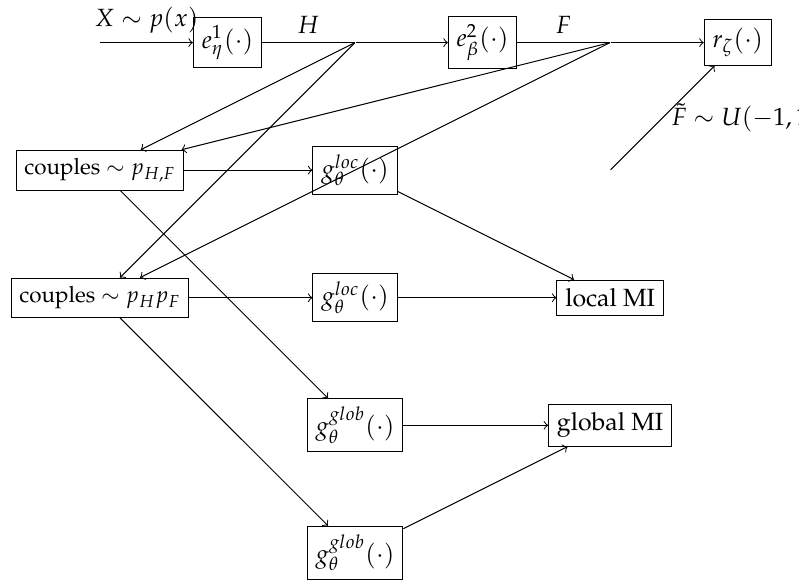
Figure A1. Deep Infomax